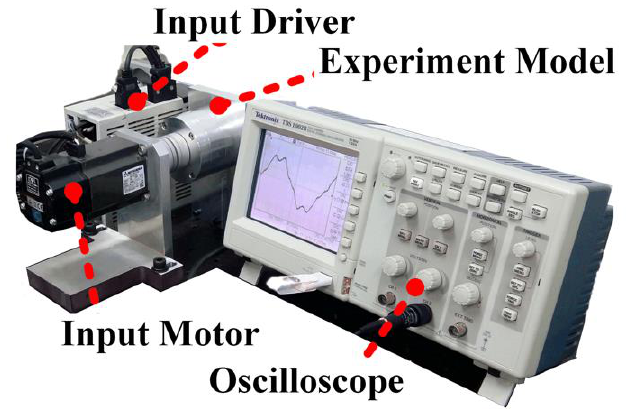
Figure 10. The experiment system for validation of the equivalent magnetic circuit method through measuring the back-EMF.